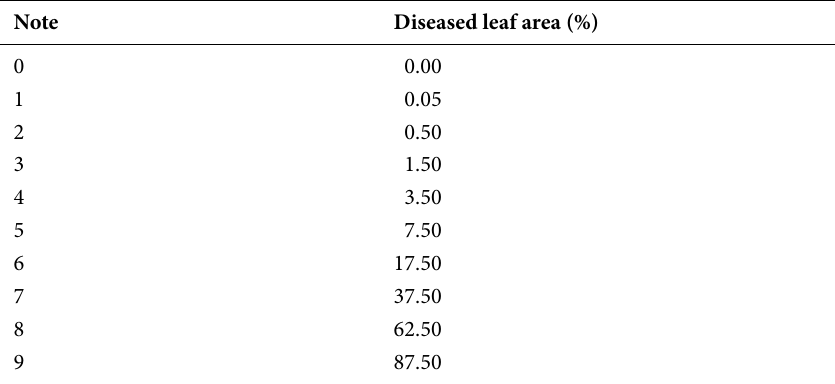
Table 1 Disease rating scale (Notteghem et al.,